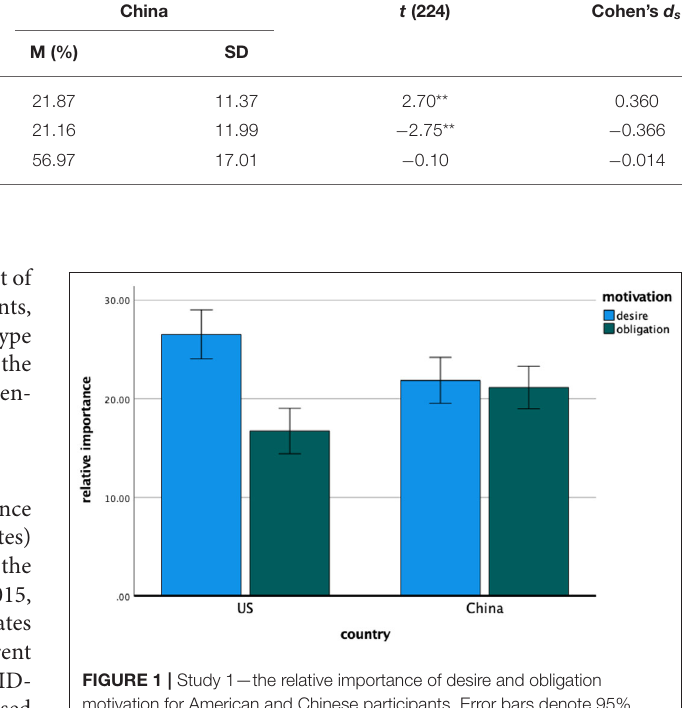
TABLE 3 | Descriptive data for motivations included in relative importance measure among Chinese and American participants. Motivation